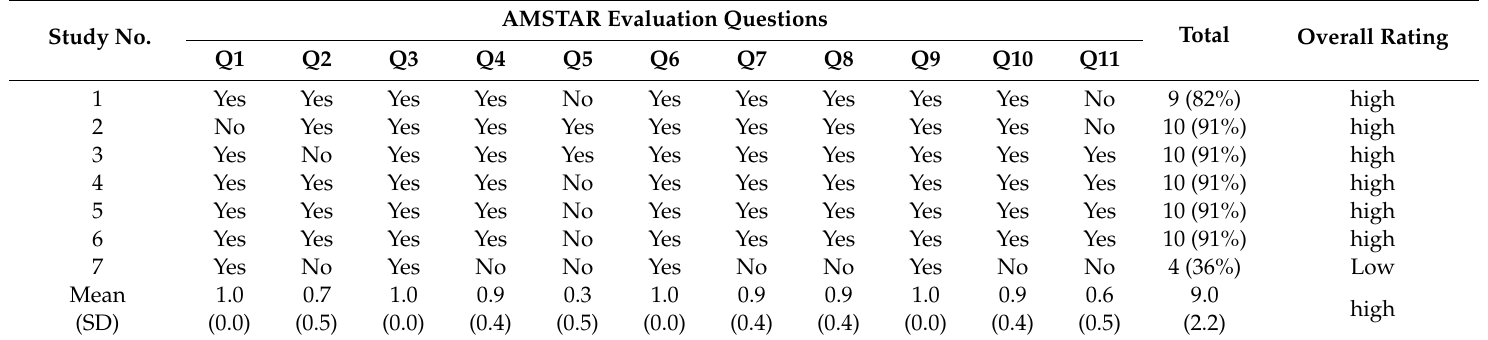
Table 4. Quality evaluation using AMSTAR.